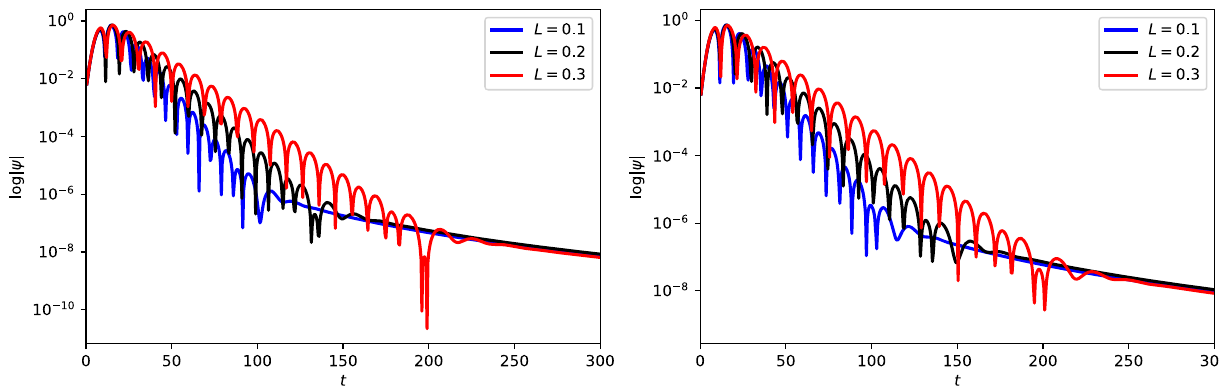
Fig. 5 The time-domain profiles of the scalar field perturbation (left panel) for different L with M = 0 . 5 , l = 1 , a = 0 . 1. The time-domain profiles of the electromagnetic field perturbation (right panel) for different L with M = 0 . 5 , l = 1 , a = 0 .